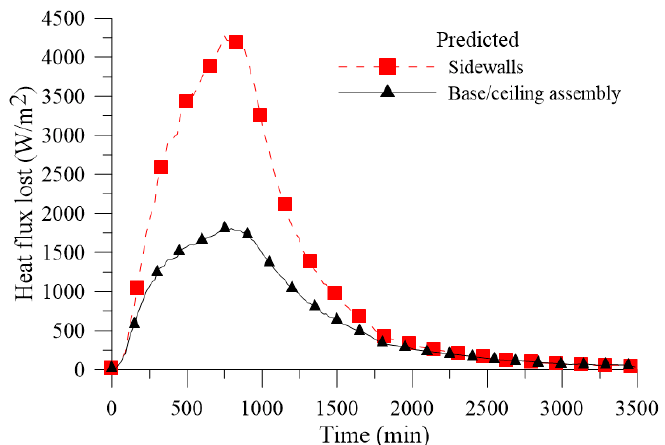
Figure 12. Comparison between the specific heat fluxes lost by the sidewalls and the base/ceiling assembly of the kiln as a function of time.